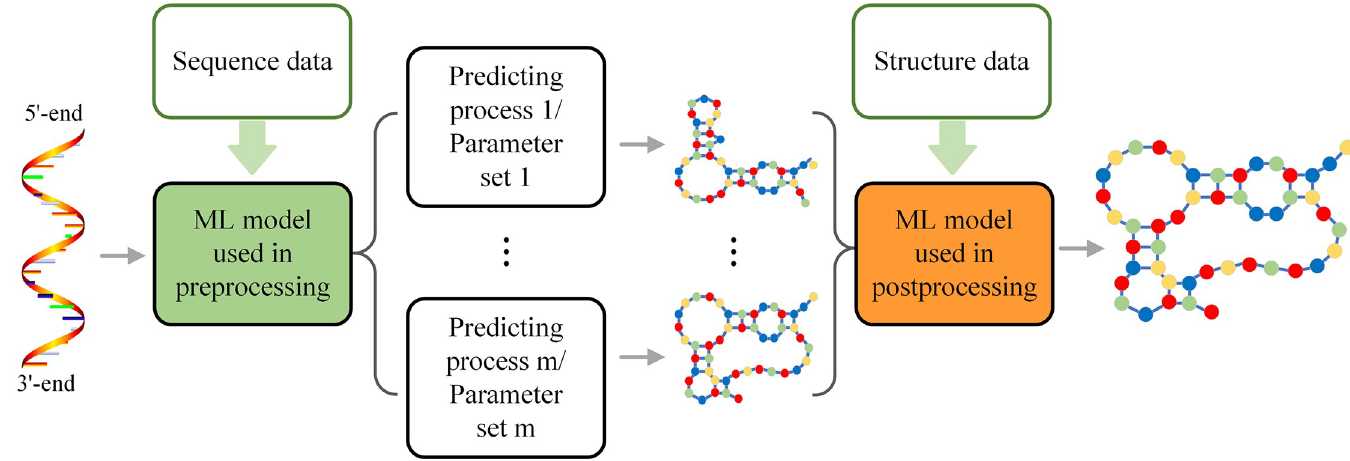
Fig 3. Framework for RNA secondary structure prediction methods with ML-based preprocessing or postprocessing. In RNA secondary structure prediction, ML models (trained by sequence data, in green) can be also used in pretreatment for selecting an appropriate prediction method or a group of appropriate parameters; ML models (trained by structure data, in brown) also can provide a means of determining the most likely structures among the outcomes.